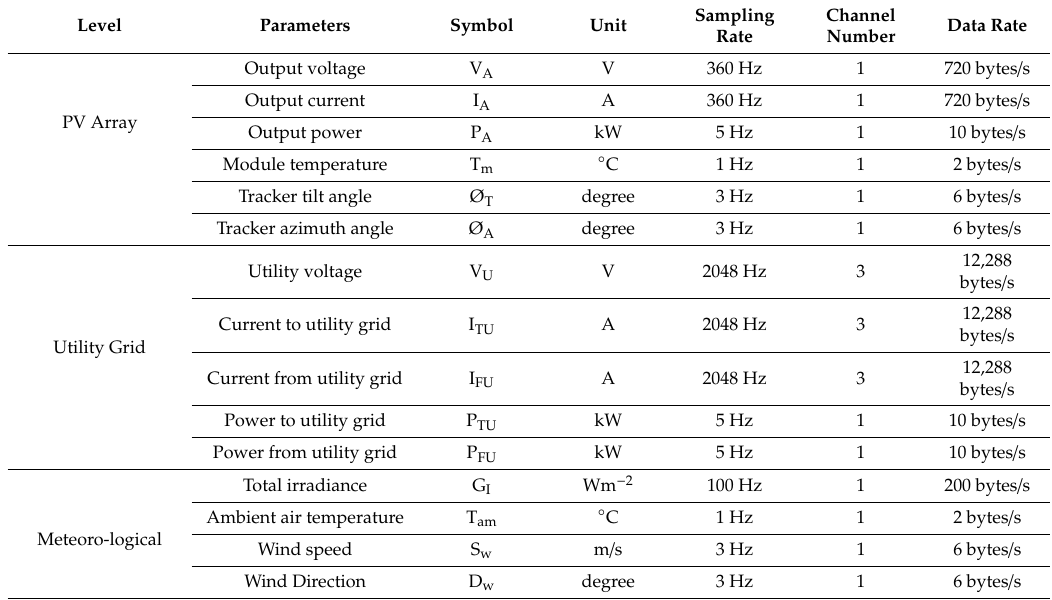
Table 3. Measured parameters for the photovoltaic system based on IEC 61724